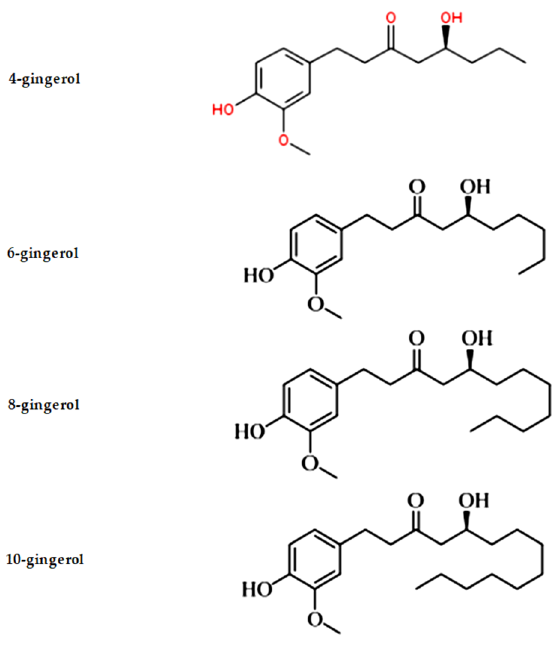
Figure 1. Structure of gingerols.